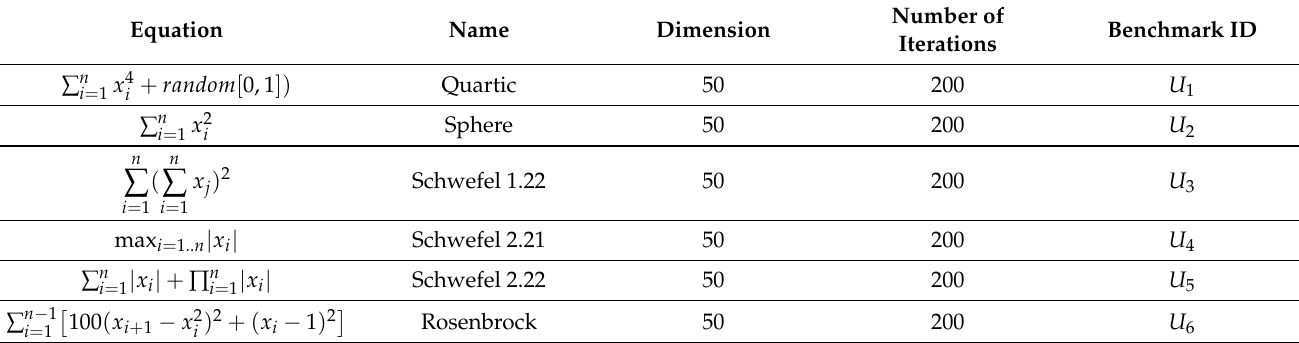
Table 5. Unimodal benchmark functions used.